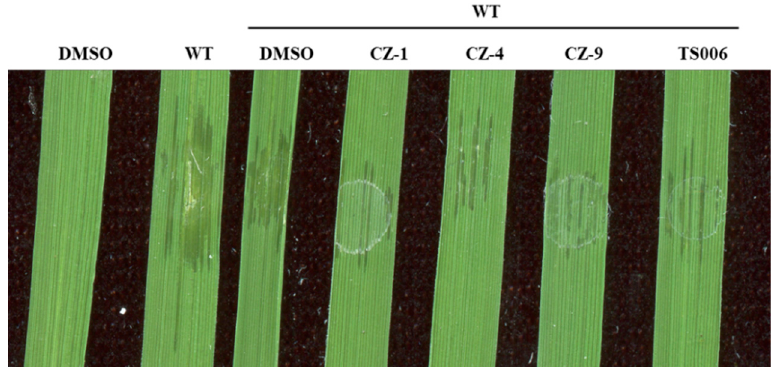
Figure 8. The impact of CZ-1, CZ-4, CZ-9 and TS006 on disease symptoms caused by infiltration of Xoc RS105 (wild-type, WT) in IR24 seedlings. Photographs were taken 3 days after infiltration. At least three independent tests were performed with similar results.